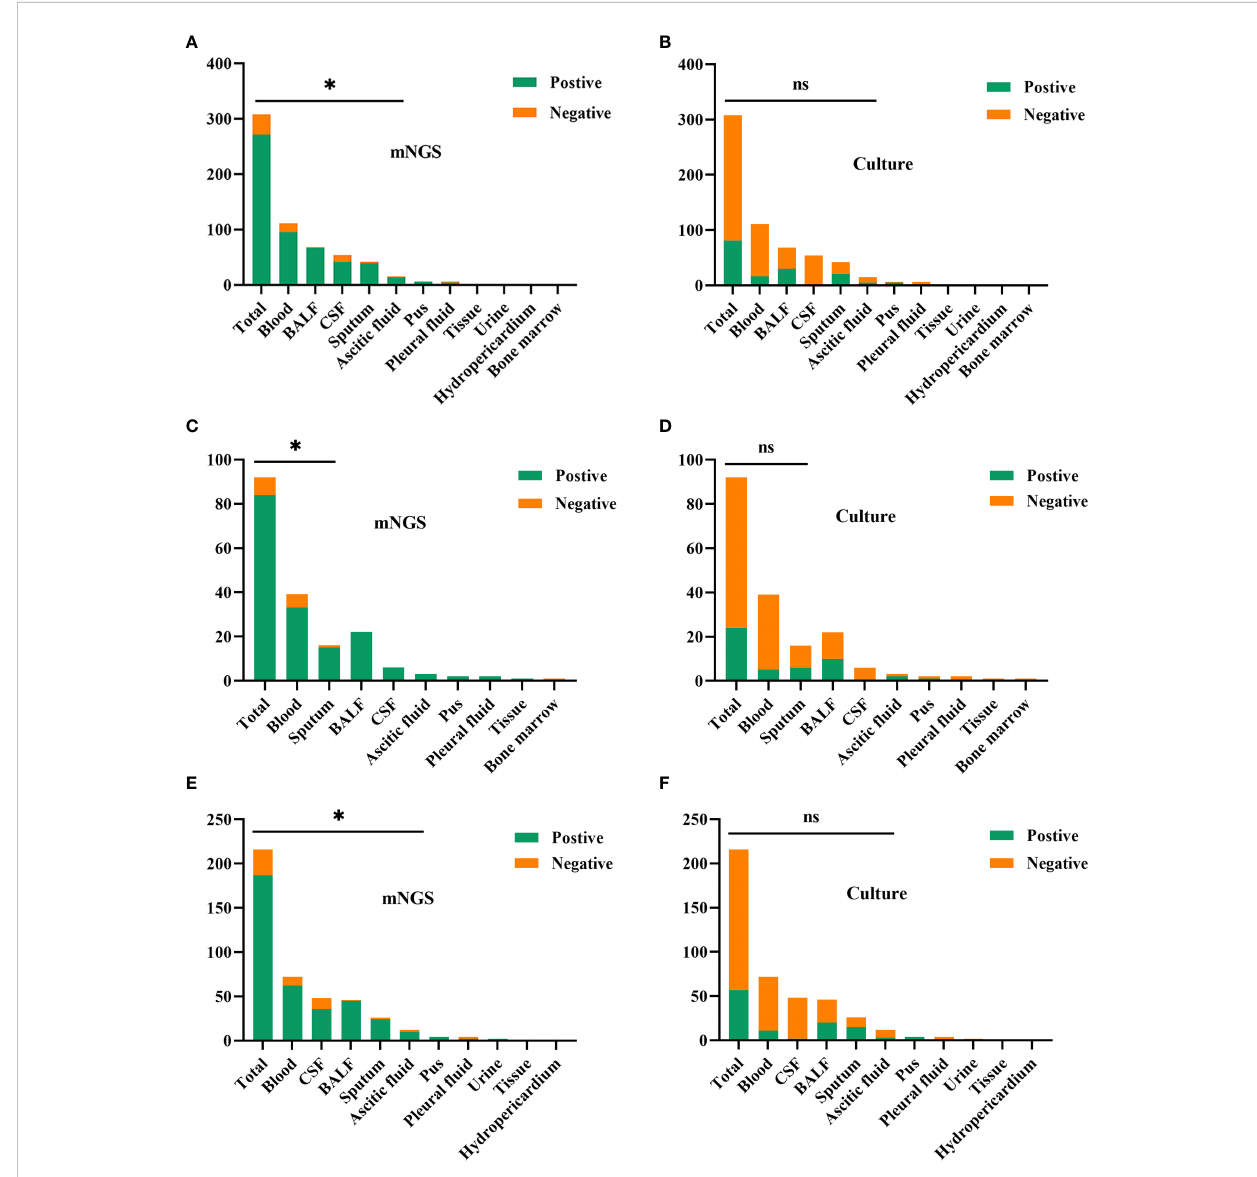
FIGURE 3 The comparison of positive rates between mNGS and culture method in sample types. (A, B) In all samples, there was considerably higher sensitivity in mNGS than those in the culture method in the types of blood (P < 0.001), BALF (P < 0.001), CSF (P < 0.001), sputum (P < 0.001) and ascitic fl uid (P = 0.008). (C, D) In the immunocompromised group, mNGS results demonstrated more sensitivity than the culture method in the types of blood (P < 0.001), and sputum (P = 0.004). (E, F) In the control group, there was more sensitivity in mNGS than those in the culture method in the types of blood (P < 0.001), BALF (P < 0.001), CSF (P < 0.001), sputum (P = 0.004) and ascitic fl uid (P = 0.016). mNGS, metagenomic next-generation sequencing; BALF, bronchoalveolar lavage fl uid; CSF, cerebrospinal fl uid. * p < 0.05; ns, no signi fi cant